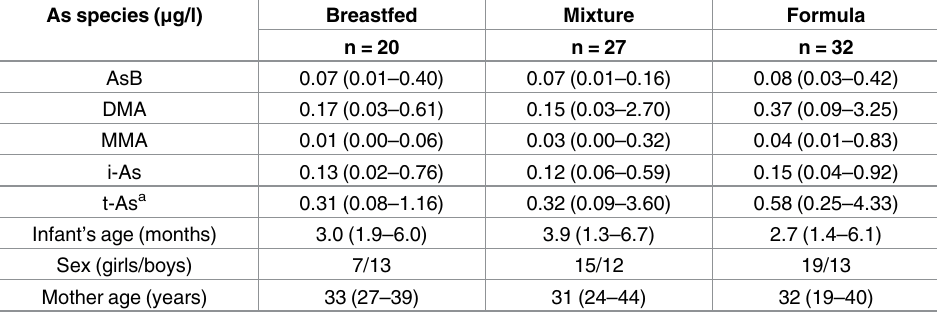
Table 1. Urinary As speciation concentration ( μ g/l) and selected characteristics of the study popula- tion according to the feeding mode before weaning. As species ( μ g/l)